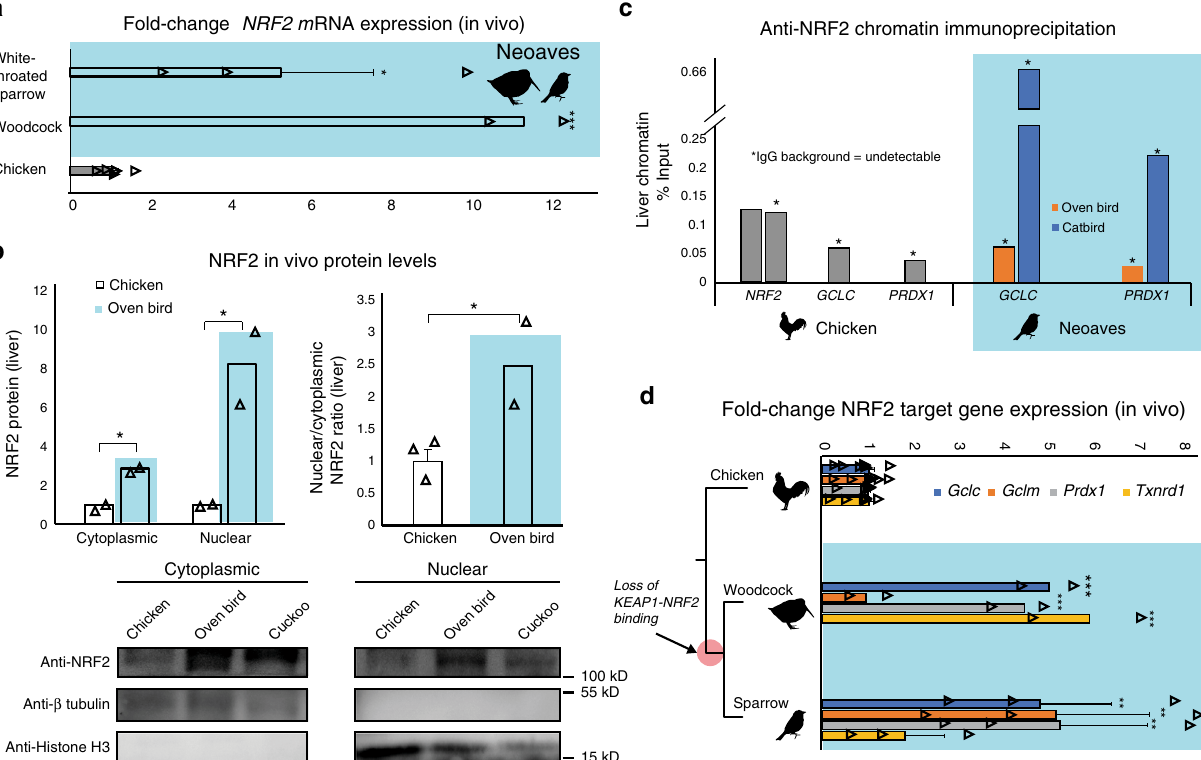
Fig. 2 Neoaves NRF2 is functional and upregulated in vivo within wild birds. a Relative to Chicken ( Gallus gallus ; [ N = 6 biologically